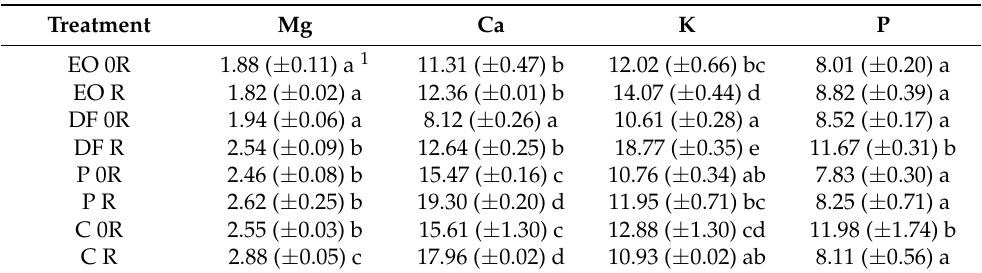
Table 6. The effect of PDSs and bioremediation on the content of magnesium, calcium, potassium and phosphorus in the leaves of Vicia faba L. (g kg − 1